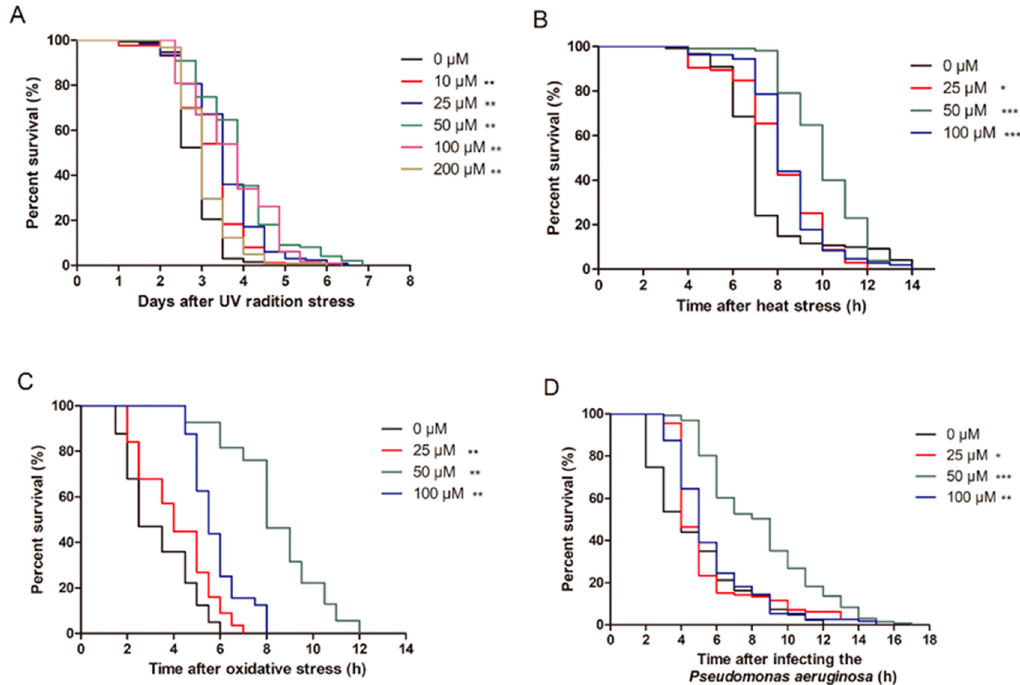
Figure 1. The effects of ellagic acid on the wild-type nematodes N 2 under various stresses. ( A ) L4- stage worms were cultured on NGM plates containing 0, 10, 25, 50, 100, and 200 μ M ellagic acid for two days and then exposed to a UV radiation dose of 1000 J/cm 2 , n > 100. ( B ) Survival curves of the nematodes exposed to 0, 25, 50, and 100 μ M ellagic acid under thermal stress of 35 °C, n > 100. ( C ) L4-stage worms were cultured on NGM plates containing different concentrations of ellagic acid (0, 25, 50, and 100 μ M) for two days. After being exposed to H 2 O 2 -induced oxidative stress, the survival curves of the nematodes were observed every 0.5 h, n > 100. ( D ) Survival curves of the nematodes exposed to Pseudomonas aeruginosa infection with treatments of 0, 25, 50, and 100 μ M ellagic acid, n > 100. p < 0.5 (*), p < 0.01 (**), and p < 0.001 (***).